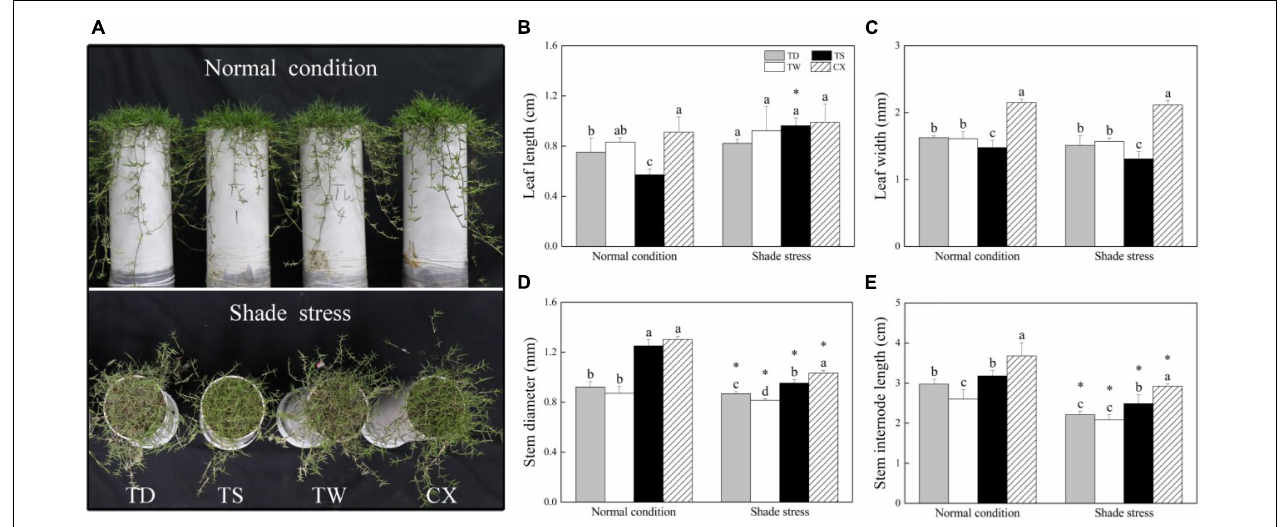
FIGURE 1 | Effects of shade stress on (A) phenotype, (B) leaf length, (C) leaf width, (D) stem diameter, and (E) stem internode length of four bermudagrass cultivars. Vertical bars indicate the ± SE of mean ( n = 5). Different letters above columns indicate significant differences ( p ≤ 0.05) among the four cultivars under normal conditions or shade stress. The asterisk ( ∗ ) above the letter indicates a significant difference ( p ≤ 0.05) in one particular cultivar between normal conditions and shade